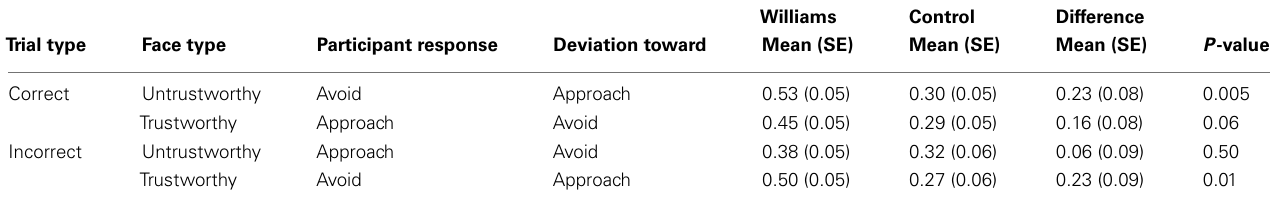
Table 3 | Maximum deviation forWS and control participants, for correct and incorrect trials.Adjusted for age, IQ, and reaction